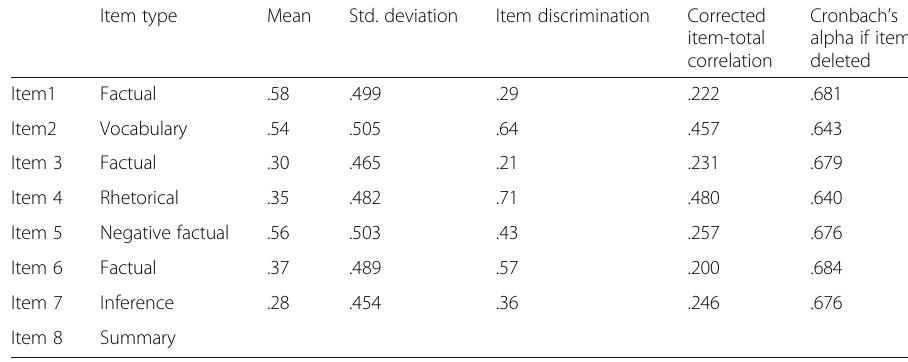
Table 4 Item analysis of the 8 MC reading items from form B ( n =